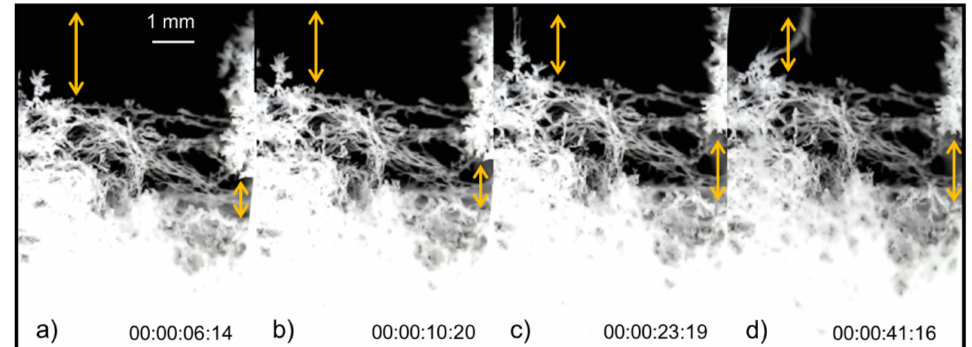
Figure 9. Frames from 6s14 to 41s16 show slight changes in the porous packed ice network triggered by the electric field. Switching the power supply 1 s before the frame in ( a ) provokes a slow displacement of the ice network from ( a – d ). The vertical yellow arrows indicate this change of position on the top-left and central-right parts of the frames. A network displacement of approximately 0.6 mm occurs where the ice appears more porous, whereas the structures in denser areas maintain their positions, with few changes.